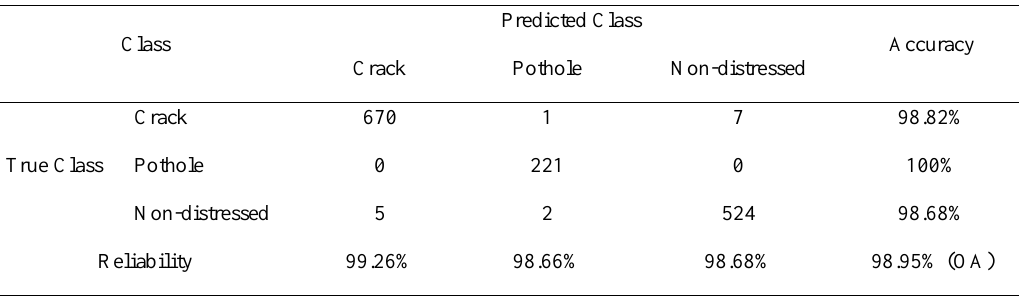
Table 3. Confusion Matrix of